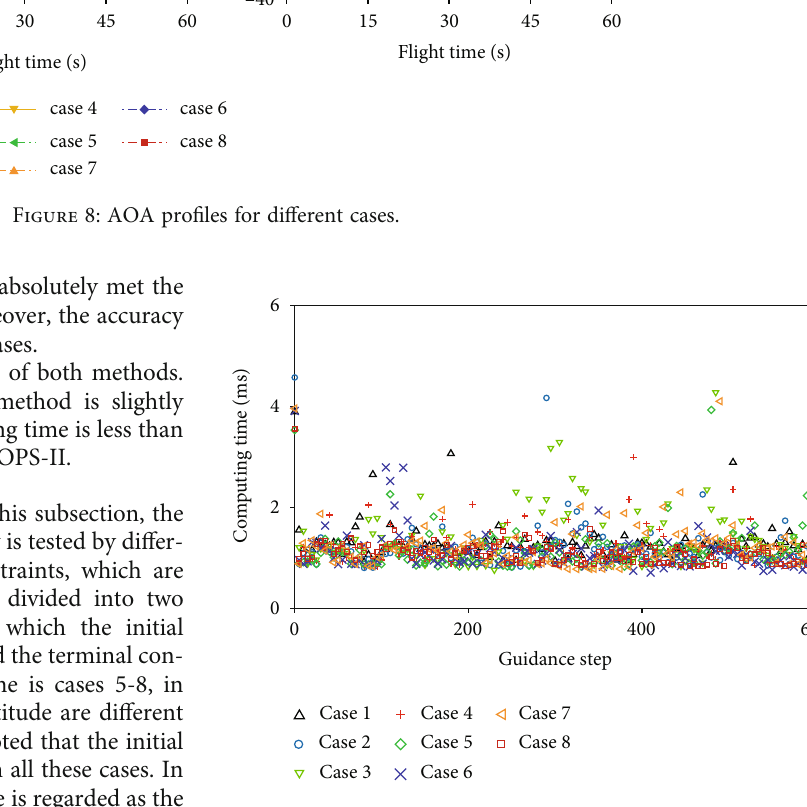
Figure 9: Consuming time at each guidance Table 8: The dispersion parameters of the Monte Carlo simulations.